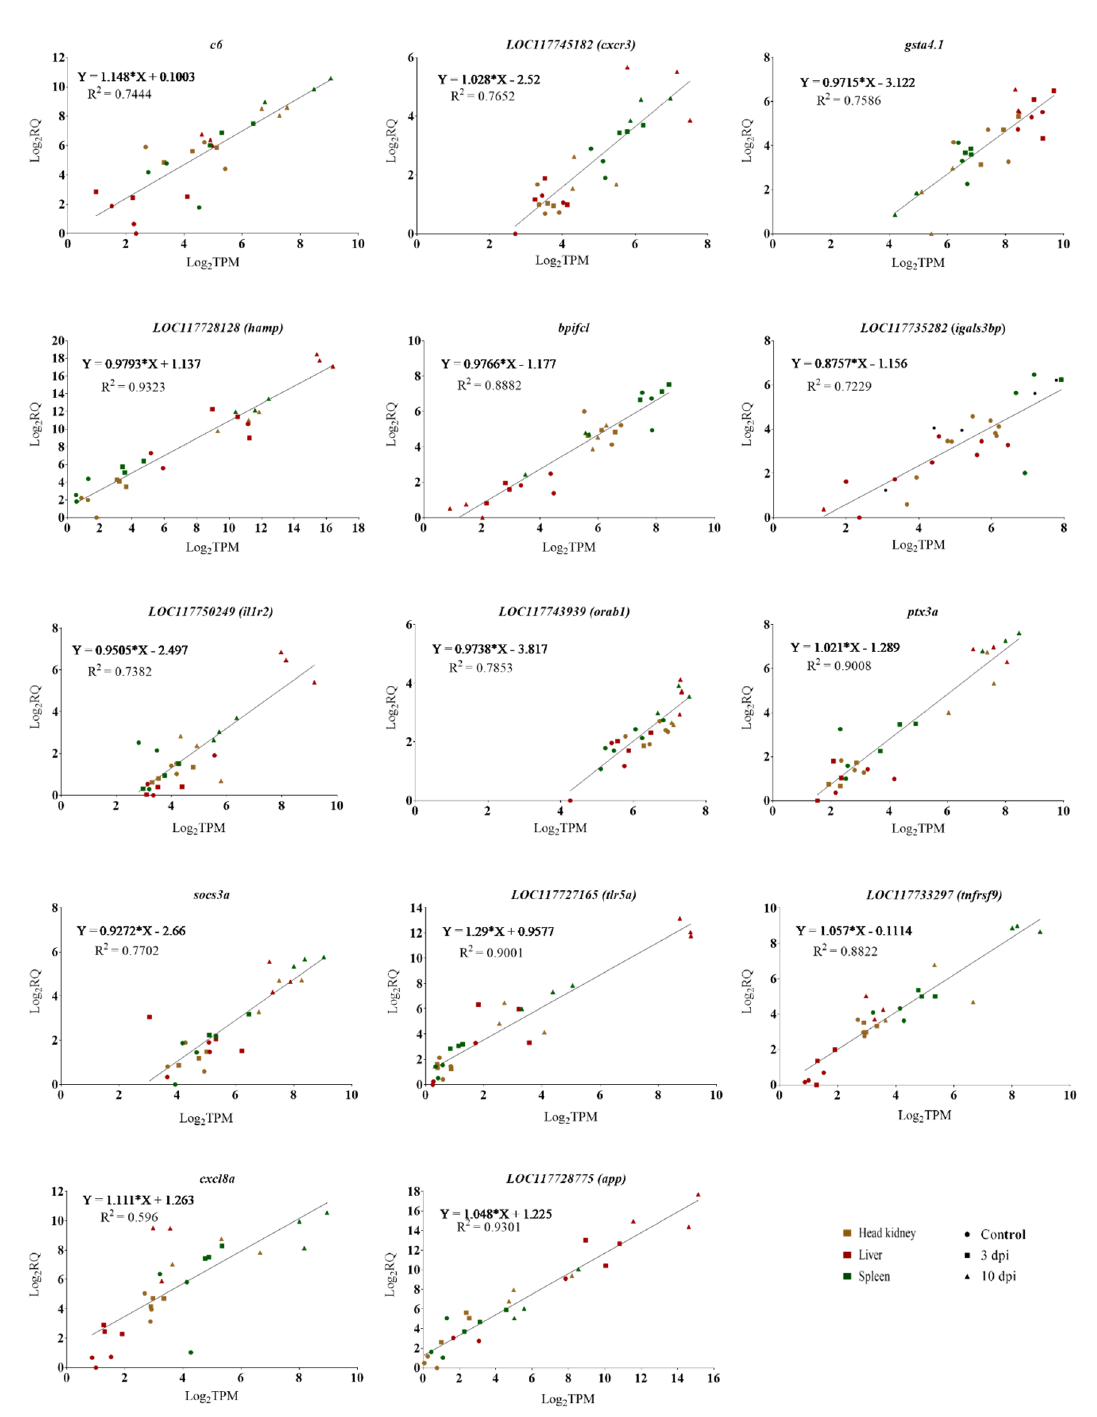
Figure 11. Gene expression correlation between RT-qPCR and RNA-Seq data of 14 selected DEGs . RNA-Seq data are presented as log 2 TPM (X-axis), and RT-qPCR data are represented as log 2 RQ (Y-axis). Three different colours represent gene expression in the head-kidney (brown), spleen (red) and liver (green). The circle represents control samples; the square represents 3 dpi, and the triangle represents 10 dpi. Each symbol is an average of three fish at a particular time point in that tissue.